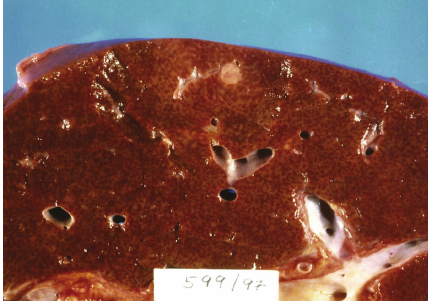
Figure 2: Gross appearance of liver in autopsy showed a few scattered, barely visible gray-whitish nodules with diameter varying from 2 to 6mm. Light microscopy clearly revealed scattered minute roundish tumours, which were declared to be